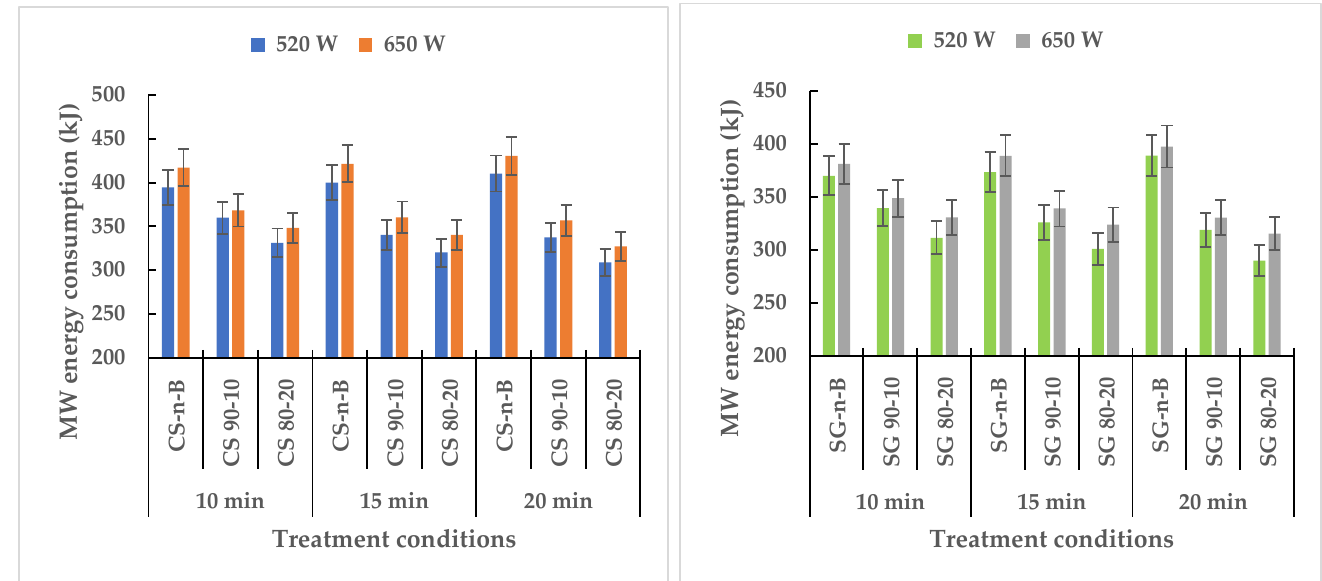
Figure 6. Microwave torrefaction energy consumption of camelina straw and switchgrass with and without biochar-mix at different power levels and torrefaction residence time. CS: camelina straw; CS-n-B: camelina straw-no-biochar; SG: Switchgrass; SG-n-B: Switchgrass-no-biochar. The first number after the biomass is % of biomass, and the second number is % of